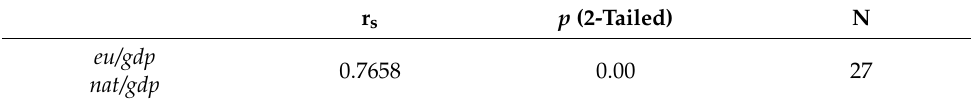
Table 9. Spearman’s correlation coefficient between the ratios eu/gdp and nat/gdp .